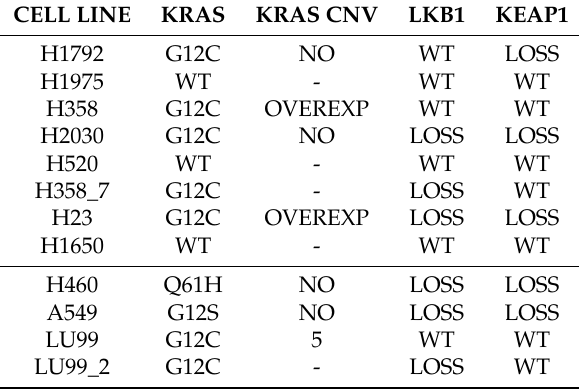
Table 1. KRAS , LKB1 and KEAP1 mutational status and KRAS copy number variation (CNV) of the NSCLC cells used, obtained by the COSMIC database [16]. Overexp: overexpression without a clear gene duplication, red: CB-839 resistant cell lines, green: CB-839 sensitive cell